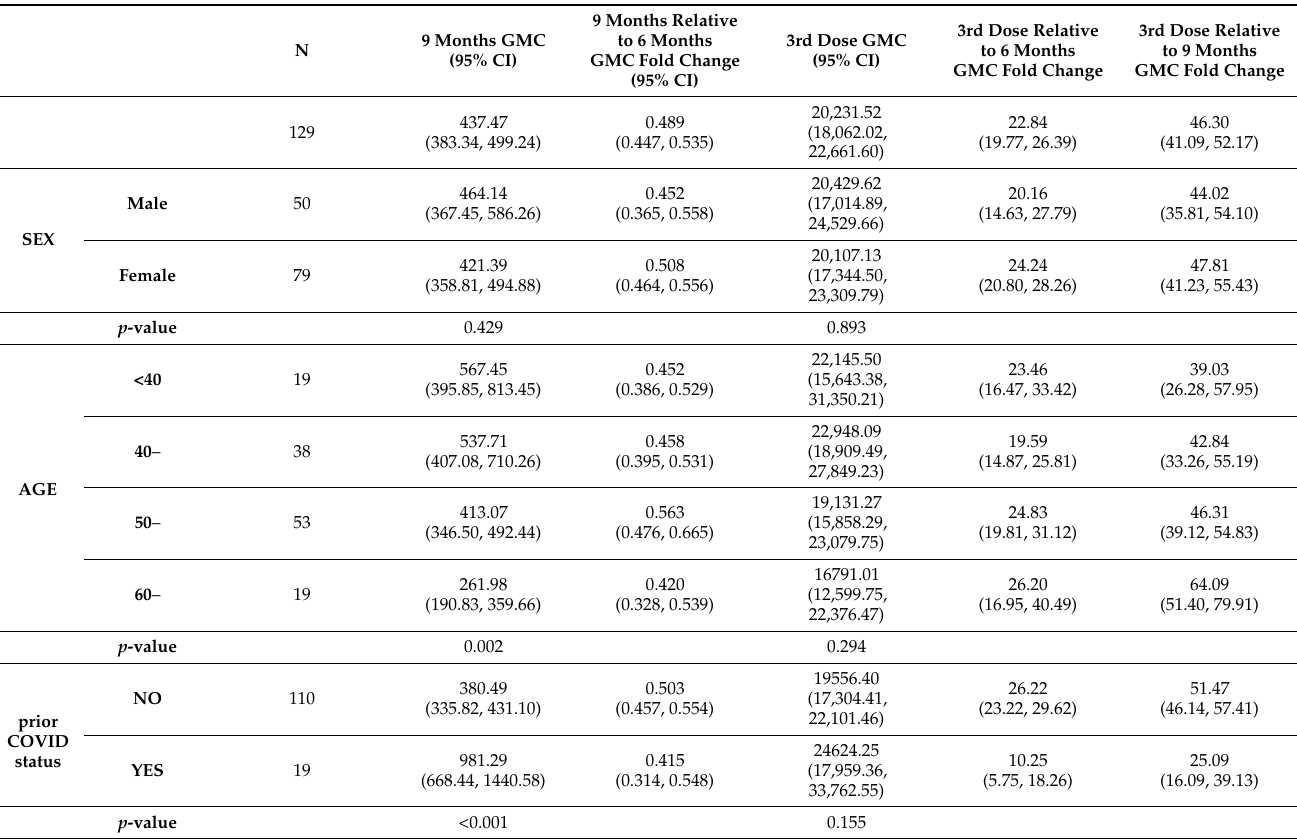
Table 1. Geometric means of concentrations (GMC)and fold changes of Anti SARS-CoV-2 Spike IgG antibodies six, nine months after two-dose vaccination and one month after the administration of the 3rd